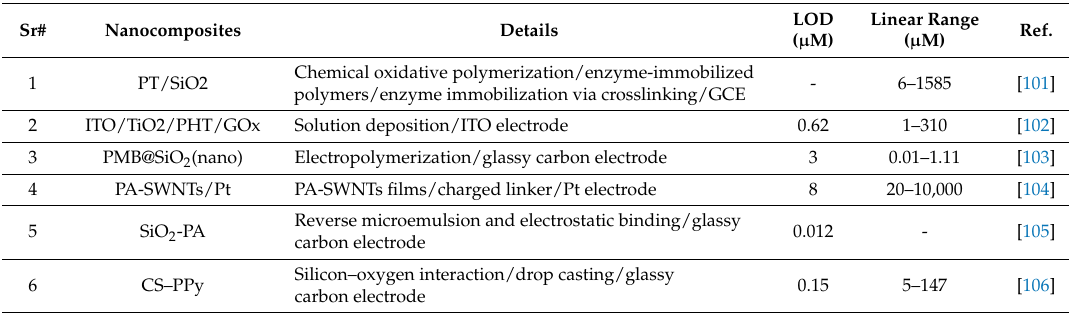
Table 3. Electrochemical glucose biosensors based on nanocomposites other than metal oxides and carbon